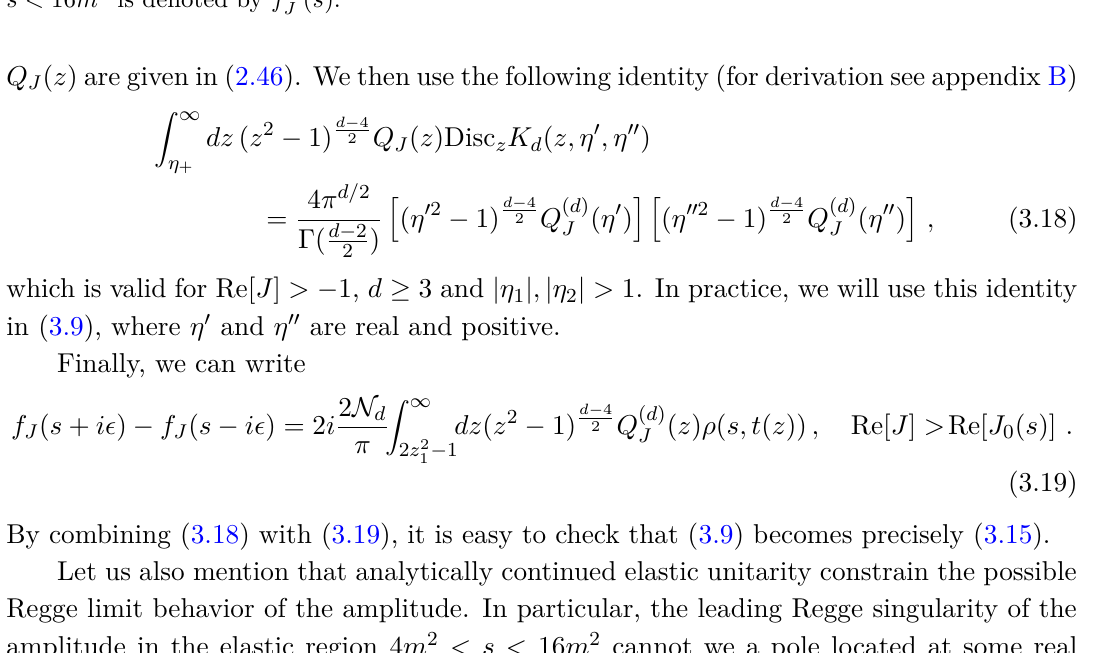
Figure 5 . The analytic continuation of f J ( s ) to the second sheet through the elastic cut 4 m 4 < s < 16 m 2 is denoted by f (cid:9) ( s ) J